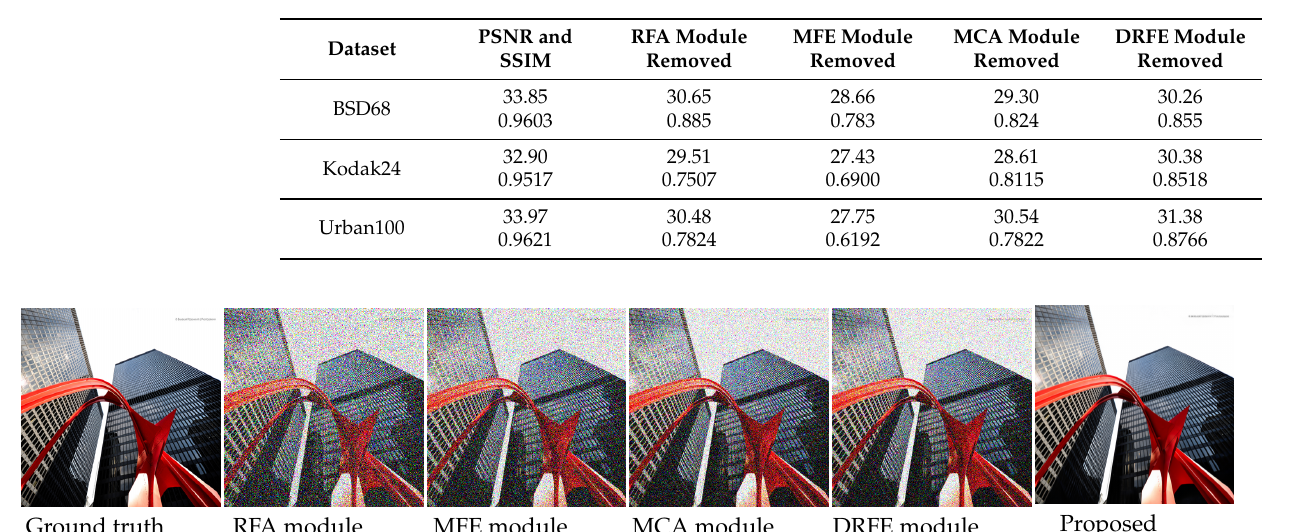
Table 4. Removing different modules from the ensemble and comparing their results on different datasets.